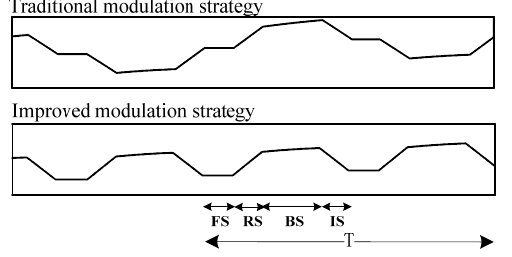
Figure 6. Partially enlarged view of v d in switching period.